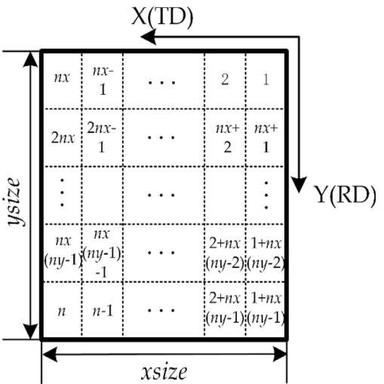
Configuration of grains in the modeling sample.